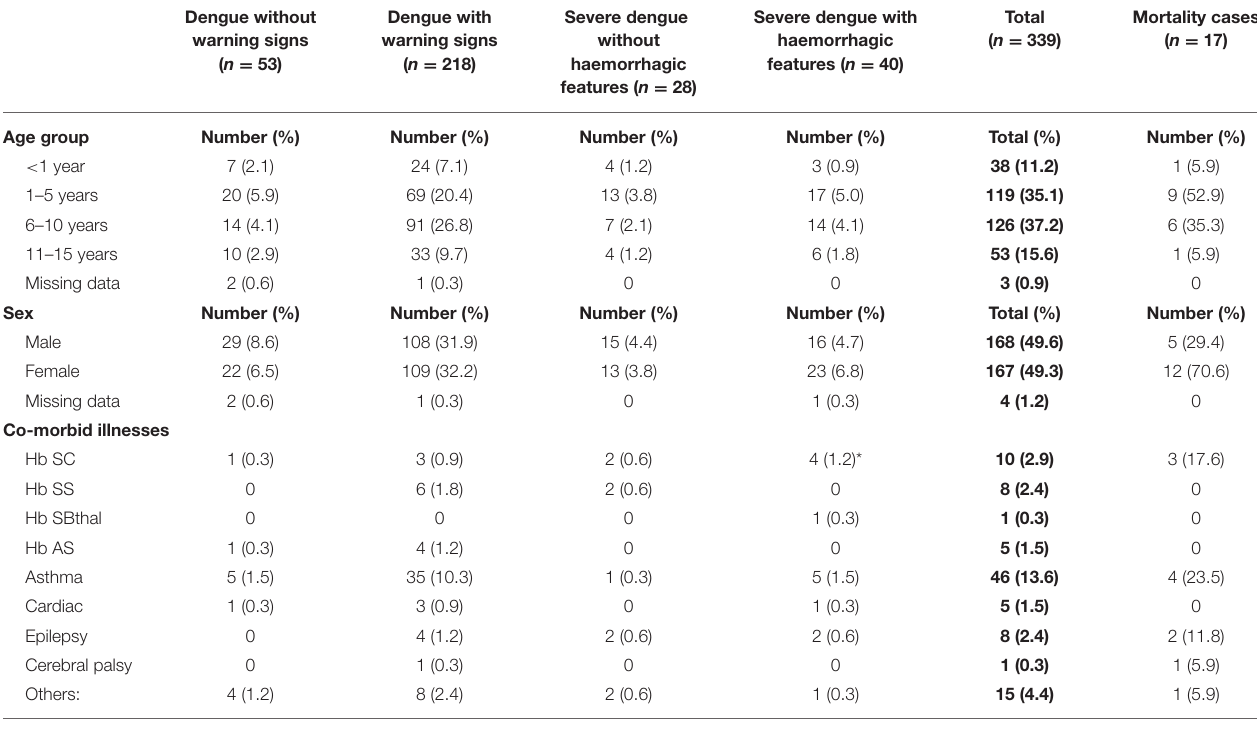
TABLE 1 | Demographics and co-morbidities in pediatric patients hospitalized with suspected and confirmed dengue in the 2018–2019 epidemic.